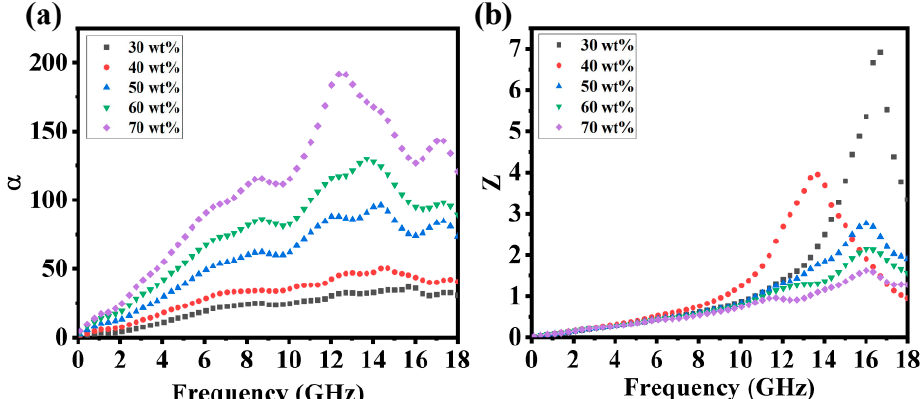
3 alloy with different filling ratios.